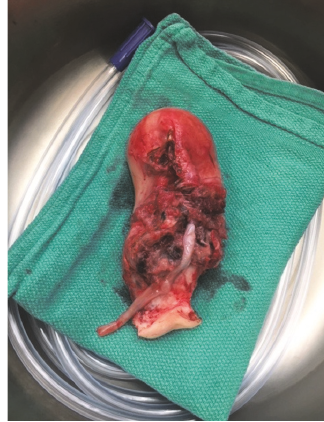
Figure 2: Gross specimen showing uterine